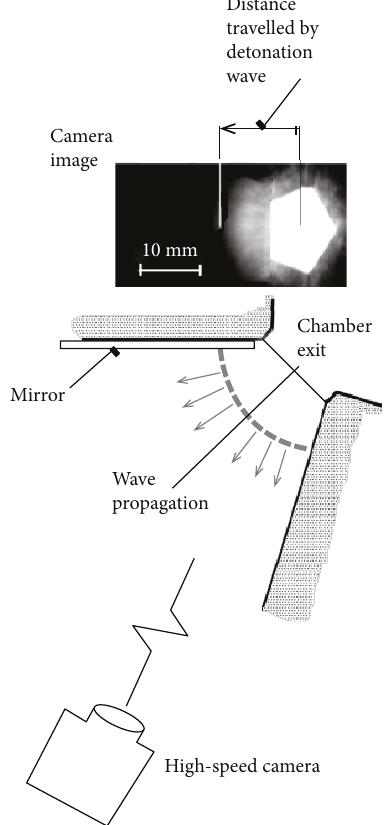
Figure 12: Schematic presentation of the setup used to measure the propagation speed of detonation waves in the chamber exit. Light- emitting wavefront position was measured in camera images. Unfortunately, the detonation progresses so fast that even with the very high-speed camera in its highest frame speed regime the timing of images was di ffi cult.